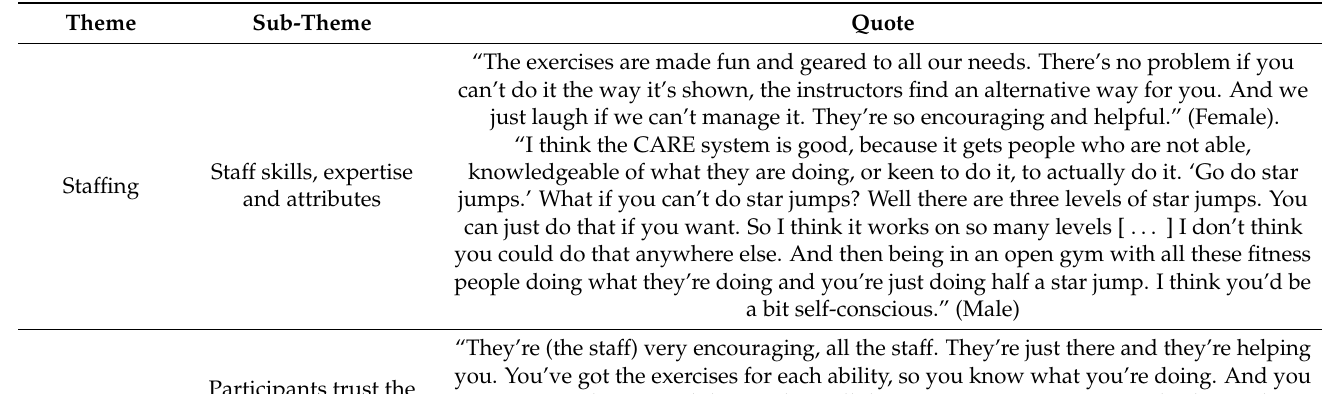
Table 8. Overall implementation themes, sub-themes and participant quotes related to their experience of